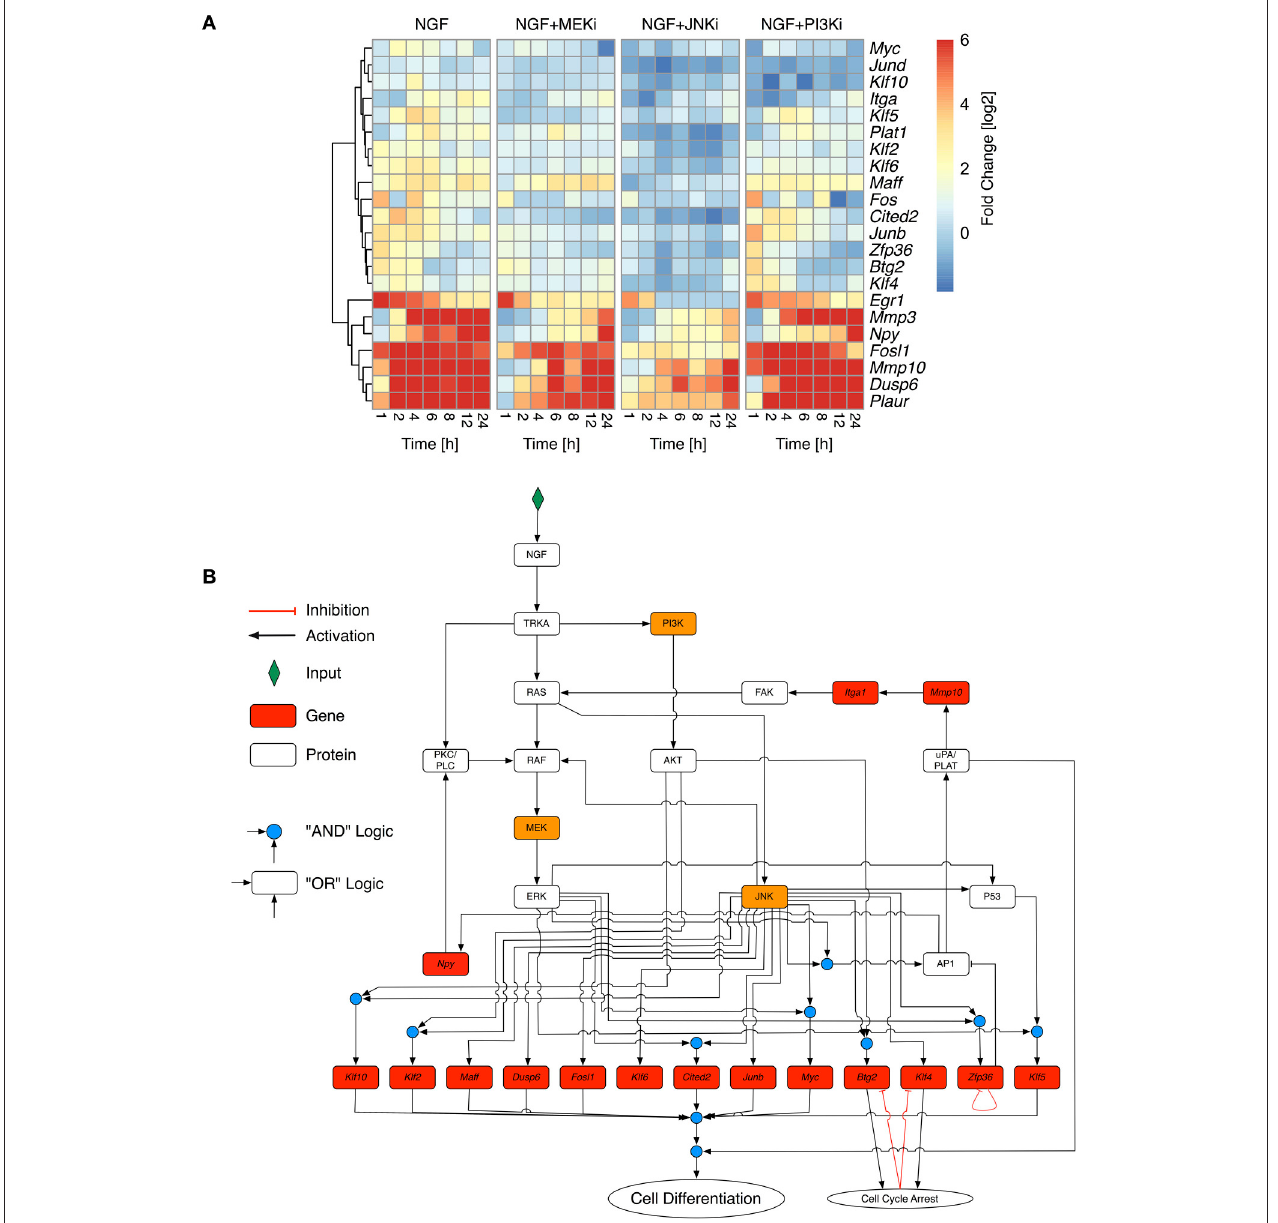
FIGURE 3 | Selective inhibition of NGF-induced PC12 differentiation. (A) Fold change values of selected response genes in PC12 cells after NGF stimulation under additional inhibition of MEK (NGF + MEKi), JNK (NGF + JNKi), or PI3K (NGF + PI3Ki). Fold change values have been calculated from biological triplicates relative to the unstimulated control per timepoint. To retain the contrast of less variable genes the maximal fold change has been restrained to + 6 . Genes have been clustered by their Euclidean distance across all conditions using a complete linkage method. (B) Optimized Boolean Network based on the training data in (A) . Nodes in red have been measured on the transcript level. Orange nodes indicate inhibited